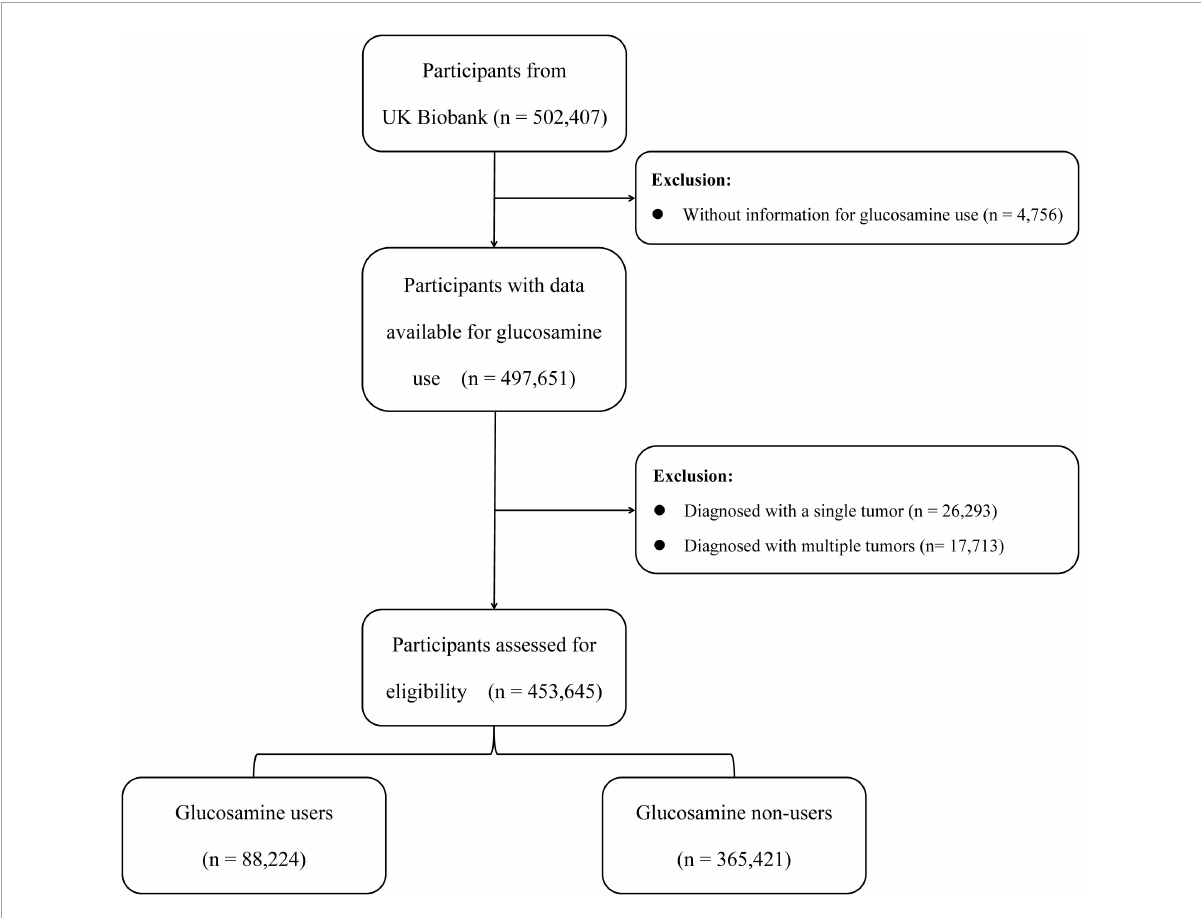
FIGURE1 Flowchart of the participants selection.